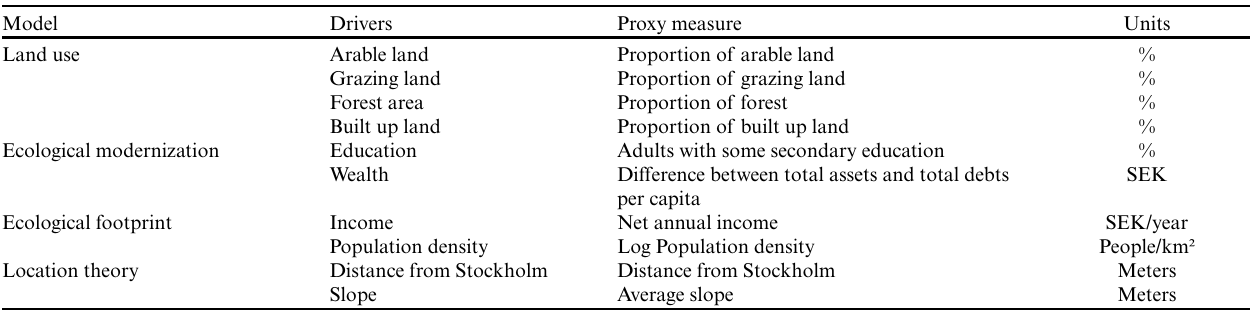
Table 1 . Models used to estimate ecosystem services and the specific drivers and proxies used in each